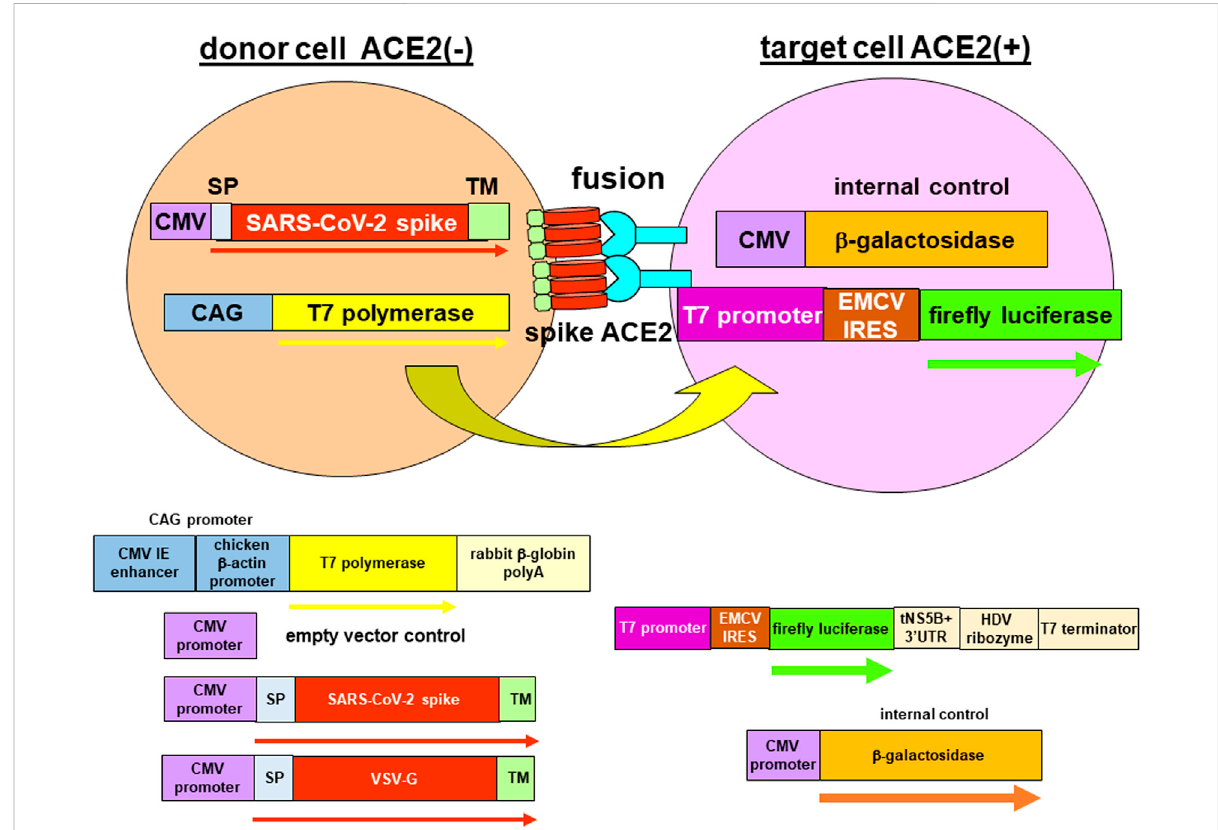
FIGURE 1 Reporter gene fusion assay. Donor cells (293T) were co-transfected with plasmids encoding the T7 polymerase together with either the empty vector (negative control) or a viral envelope protein i.e., severe acute respiratory syndrome coronavirus 2 (SARS-CoV-2) spike protein or vesicular stomatitis virus glycoprotein (VSV-G). The viral envelope proteins contain authentic signal peptides and transmembrane domains to target to the plasma membrane. Although the SARS-CoV-2 spike protein was localized to the endoplasmic reticulum-Golgi intermediate compartment, leakytransportwouldstilltargetaproportionofthespikeproteintotheplasmamembrane.Targetcells(either293T-ACE2or293T-ACE2-TMPRSS2) were co-transfected with two reporter genes expressing the luciferase protein under the T7 promoter and the internal control, β -galactosidase under the CMV promoter. Binding of the spike protein with the angiotensin-converting enzyme 2 (ACE2) protein will trigger fusion of the donor and target cells. Mixing of cytoplasmic contents enabled the T7 polymerase from the donor cells to bind to the T7 promoter in the target cells to drive transcription of the luciferase gene. The transcript was then translated from the encephalomyocarditis (EMCV) internal ribosome entry site (IRES) element to produce a luciferase read-out. Fusion was measured as a ratio of the luciferase activity to the β -galactosidase